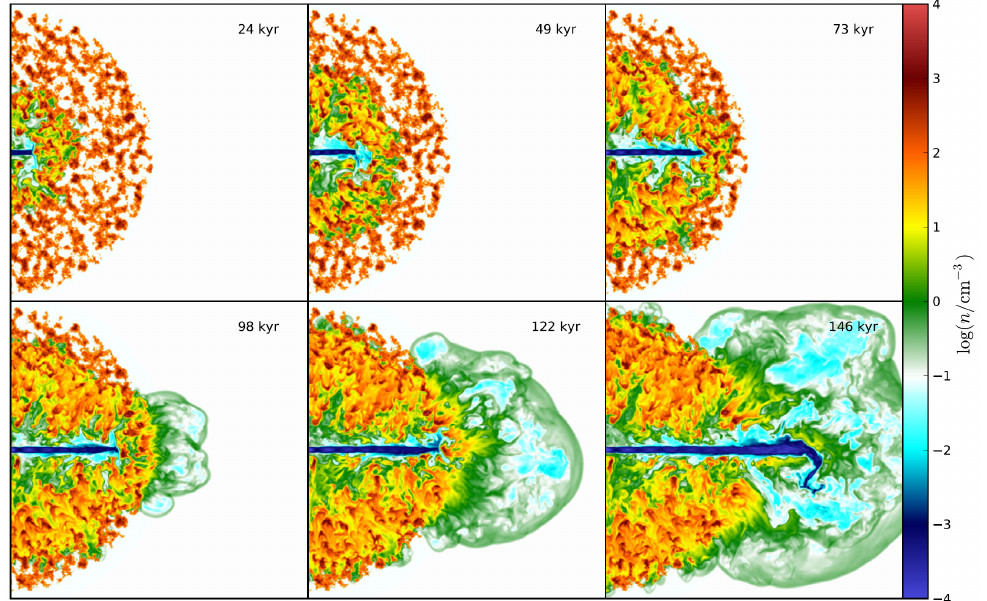
Figure 4. Figure 2 from Wagner and Bicknell [83], showing the time evolution of the jet-gas interaction in one of the simulations performed in the paper. Colors represent the different gas densities as the jet makes its way through it, being deflected towards regions of less resistance and finally creating a bubble of expanding gas. Some of the dispersed gas may reach velocities of up to ∼ 1000kms − 1